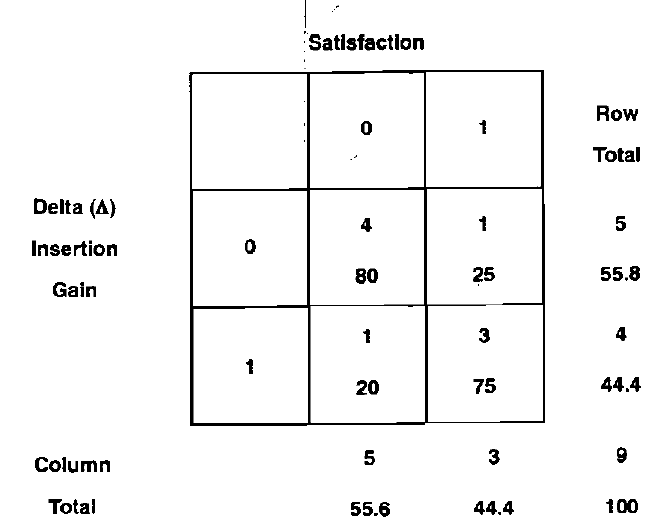
Table 6. A Correlation matrix depicting the rela- tionship between satisfaction and delta functional